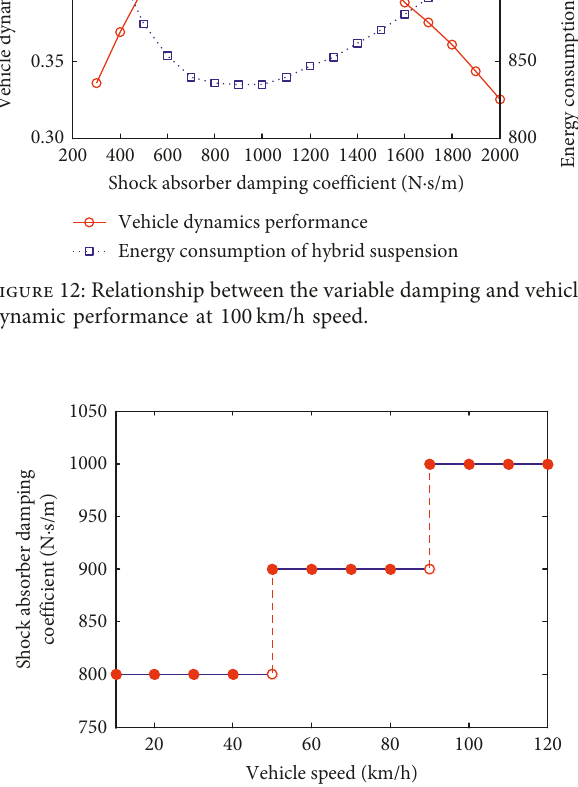
Figure 13: Suspension optimal damping at different